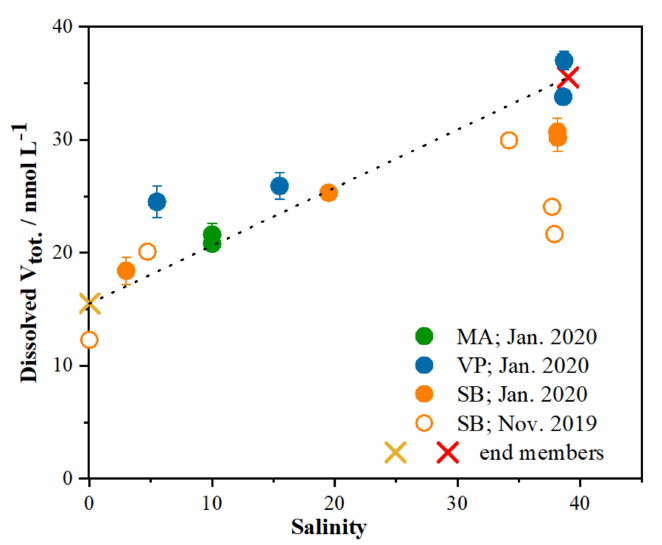
Figure 4. The relationship between the total dissolved vanadium concentration and salinity at the MA (green circles), VP (blue circles) and SB (full orange circles—January 2020; empty orange circles— November 2019) sites. The theoretical dilution line between the two end members, open sea (red cross) and the Krka River (light brown cross), is represented by the black